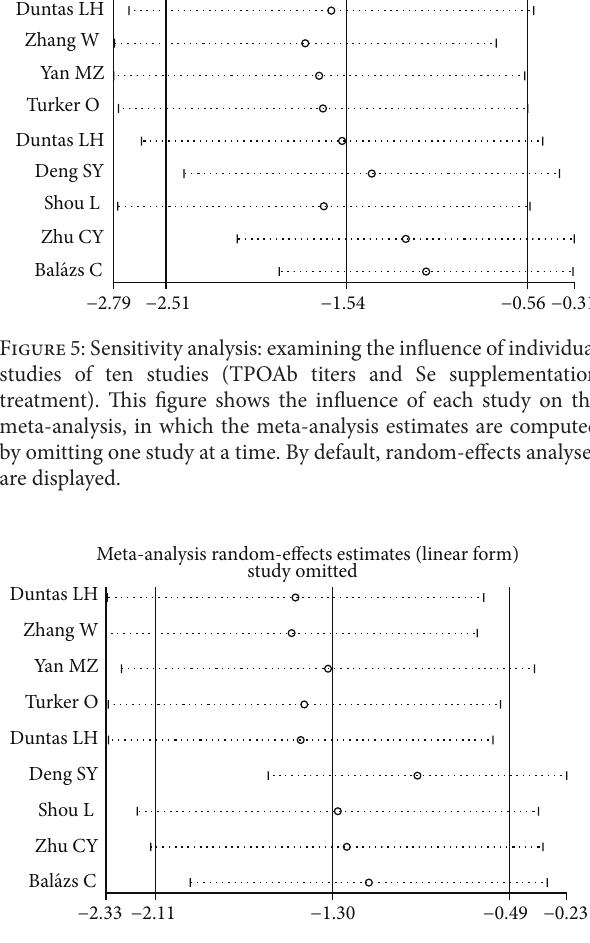
Figure 6: Sensitivity analysis: examining the influence of individ- ual studies of nine studies (TgAb titers and Se supplementation treatment). This figure shows the influence of each study on the meta-analysis, in which the meta-analysis estimates are computed by omitting one study at a time. By default, random-effects analyses are